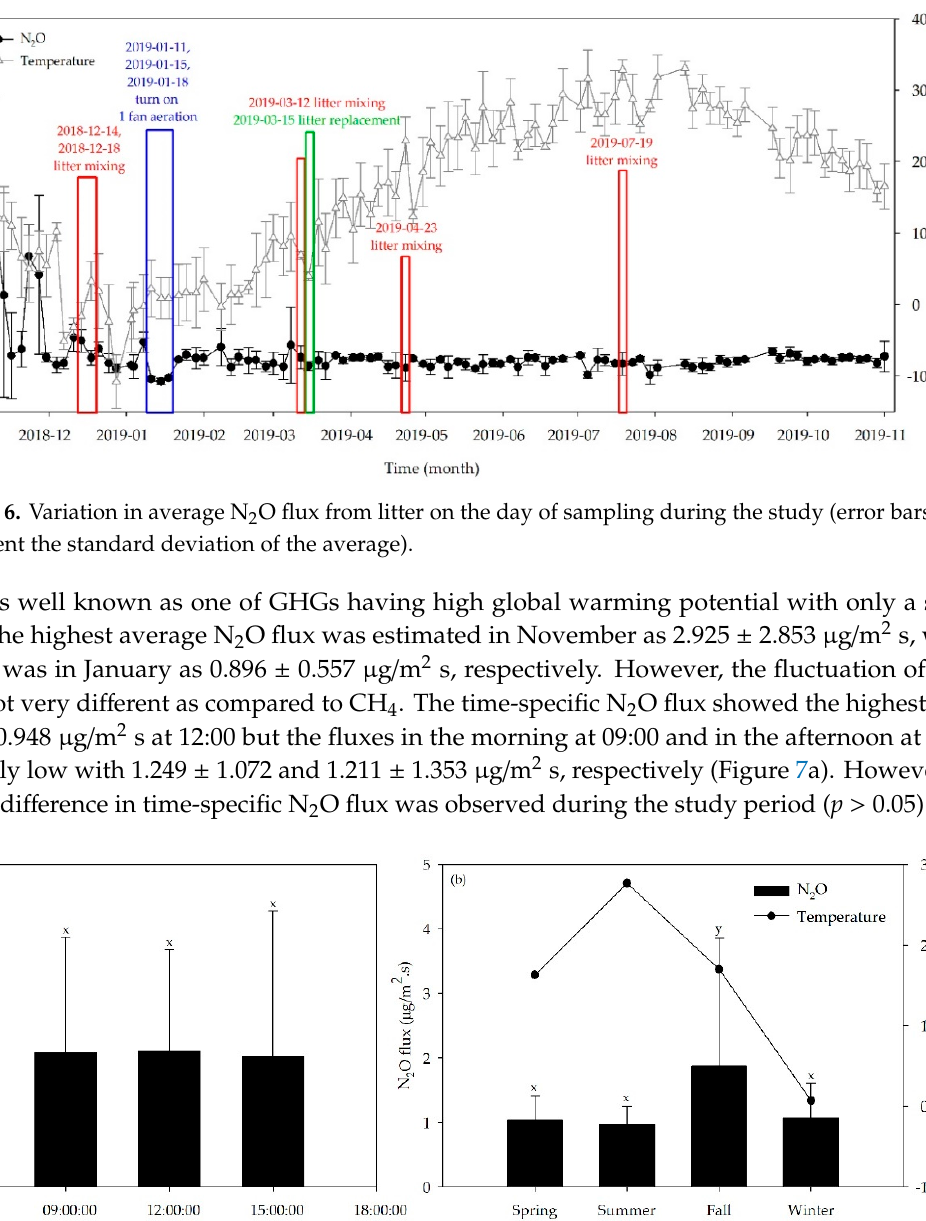
during the whole measurement period (November 2018 to October 2019).